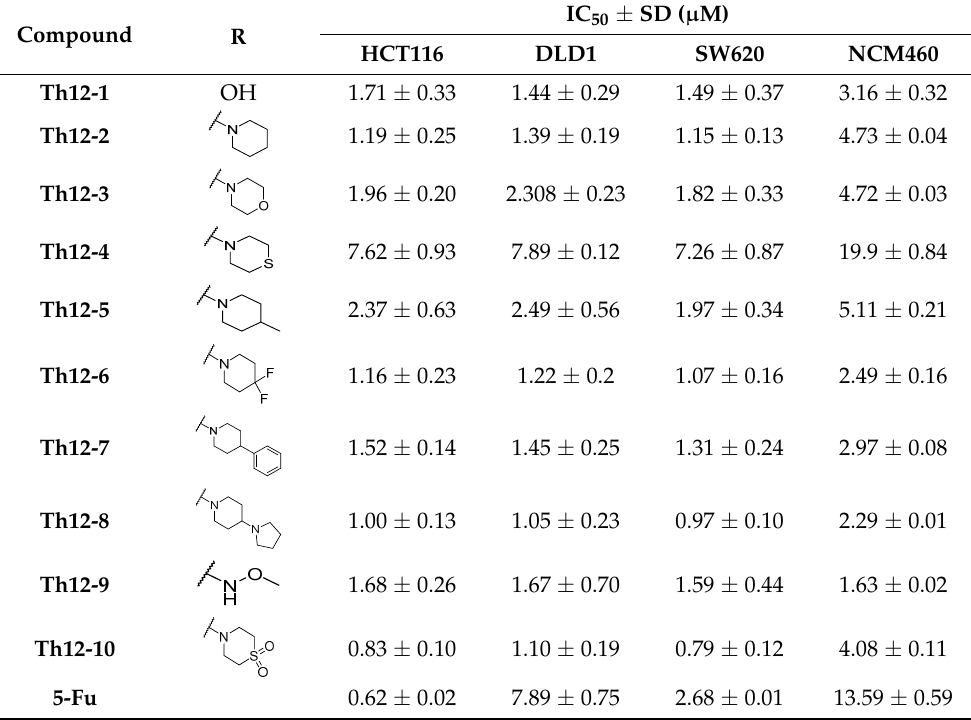
Table 2. IC 50 values ( μ M) of TH12-1 ~ TH12-10 against HCT116, DLD1, and SW620. Compound